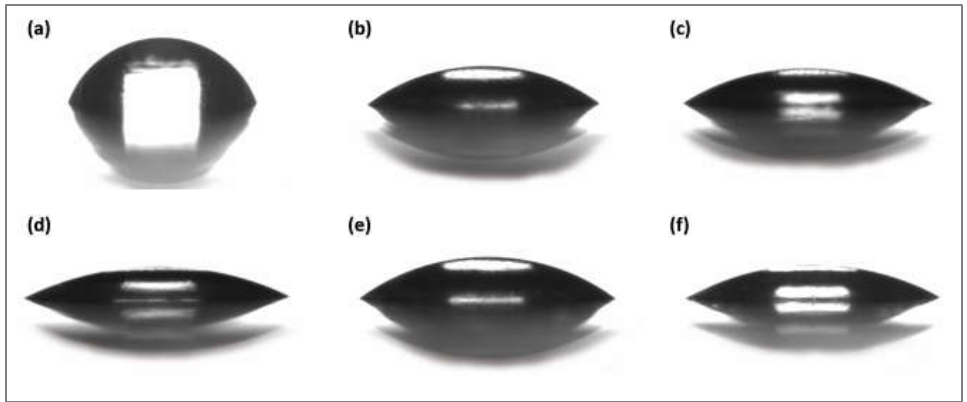
Figure 3. Water contact angle of ( a ) non-activated PLA film, ( b ) oxygen plasma-activated PLA film, ( c ) plasma-activated PLA film with a gas mixture of 25% Ar + 75% O 2 , ( d ) plasma-activated PLA film with a gas mixture of 50% Ar + 50% O 2 , ( e ) plasma-activated PLA film with a gas mixture of 75% Ar + 25% O 2 , ( f ) argon plasma-activated PLA film.